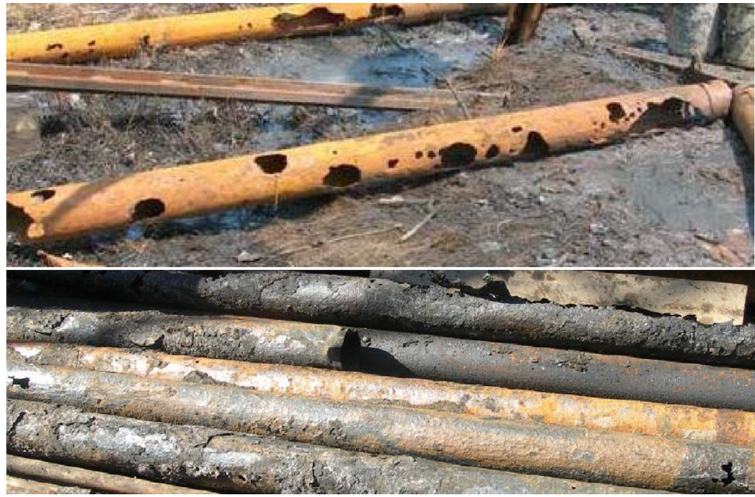
Figure 3. External steel casing corrosion from acidic water attack [32].